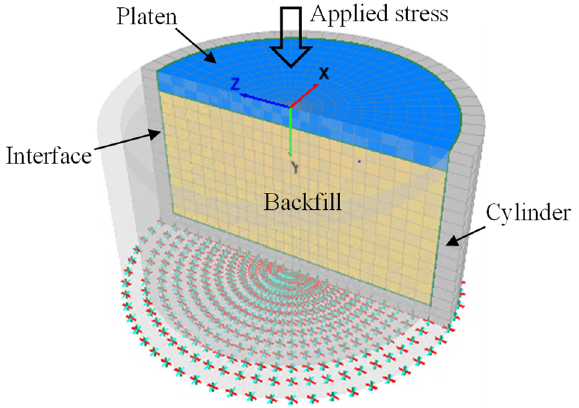
applied in the numerical simulations while the average normal displacement on the top